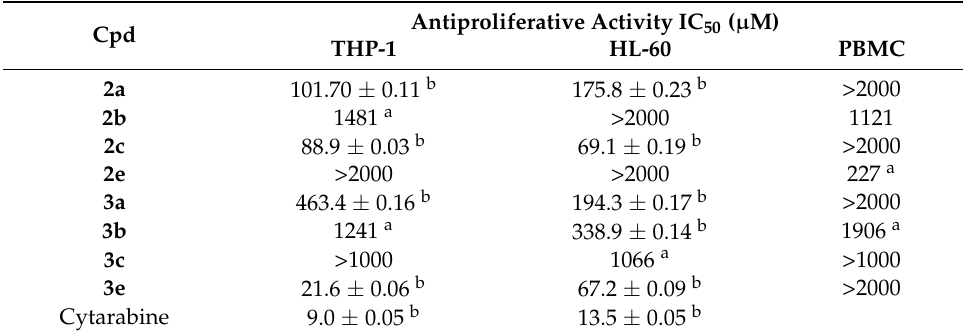
Table 2. Half inhibitory concentration (IC 50 ) calculated using sigmoidal dose-response relationship for N -(phenothiazine-3-yl)-thioamides ( 2a , 2c , 2e ), TAPTZ 3a , 3c , 3e , and cytarabine, respectively, against THP-1 and HL-60 tumour cells and normal peripheral blood mononuclear cells (PBMCs) in vitro .